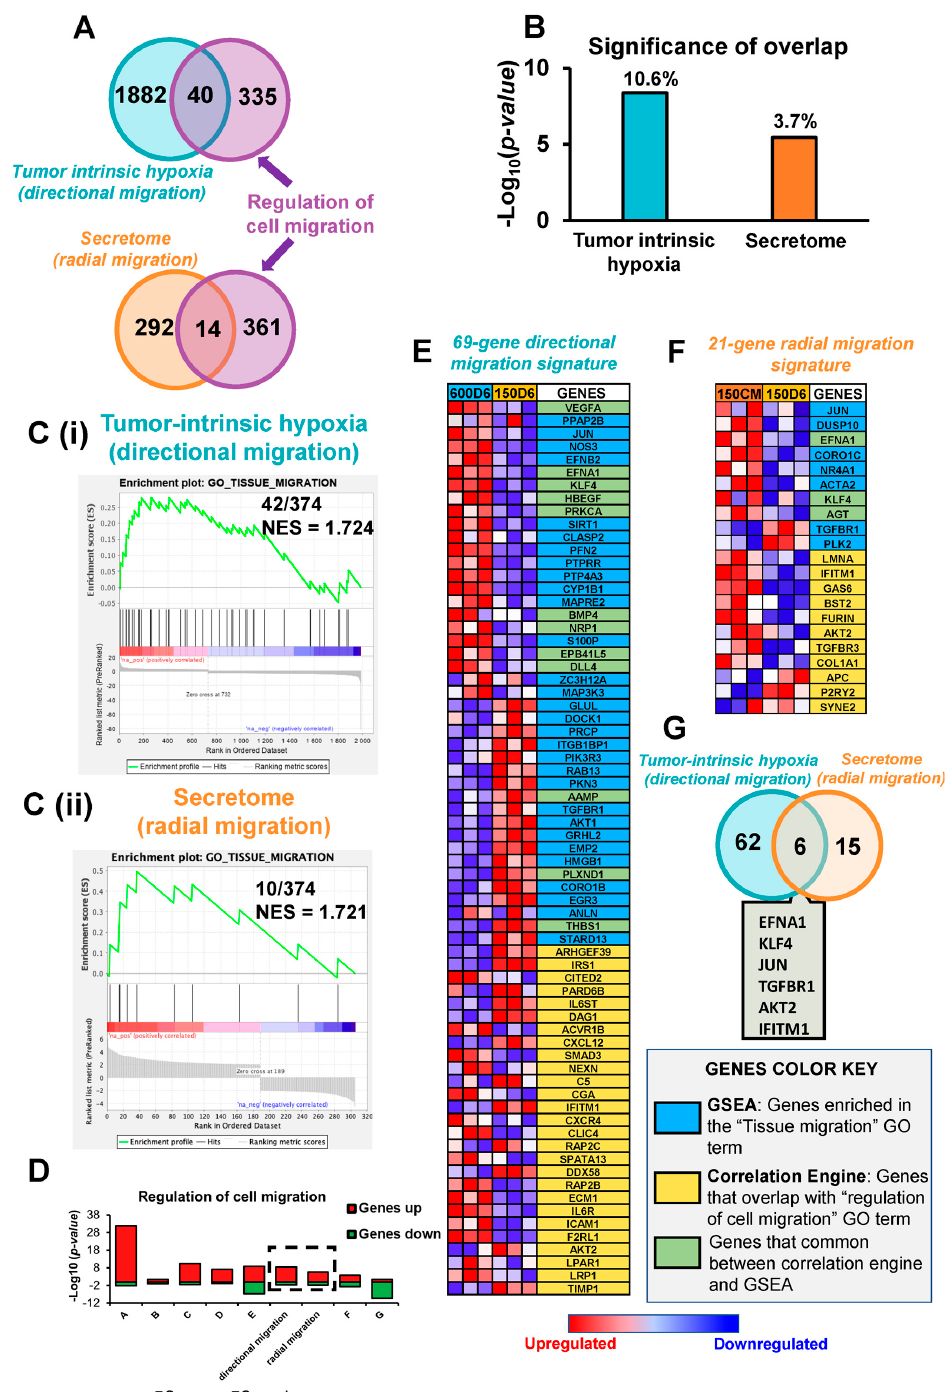
Figure 5. Migration is equally enriched in both large and small migratory tumors displaying different patterns of migration. ( A ) Venn diagram of correlation engine analysis showing the 40 common genes between tumor intrinsic hypoxia-induced directional migration and ‘regulation of cell migration’ gene ontology (GO) term, as well as the 14 common genes between secretome-induced radial migration and ‘regulation of cell migration’ GO term. ( B ) Significance of overlap ( p -value and % of overlap) of differentially expressed genes (DEGs) in hypoxia-induced directional migration and secretome-induced radial migration with ‘regulation of cell migration’ GO term. ( C ) GSEA enrichment plot of DEGs in GO ‘tissue